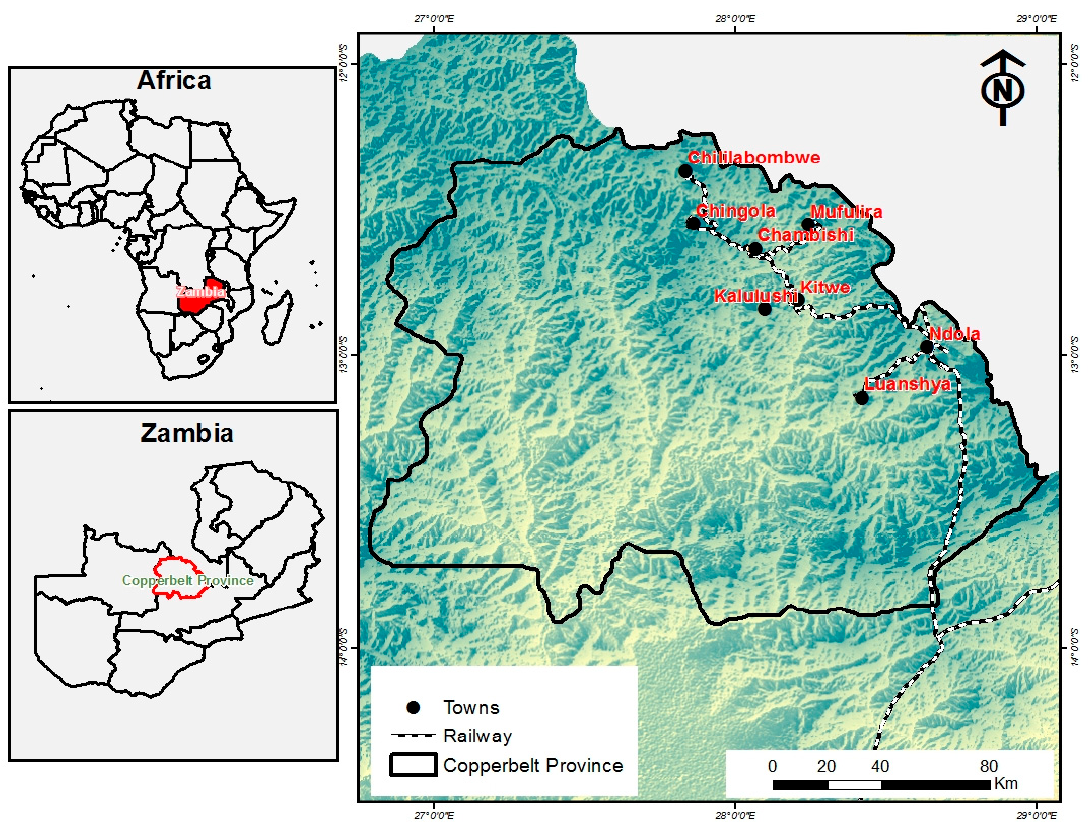
Figure 1. Administrative boundaries of Copperbelt Province of Zambia including rivers and the major towns.